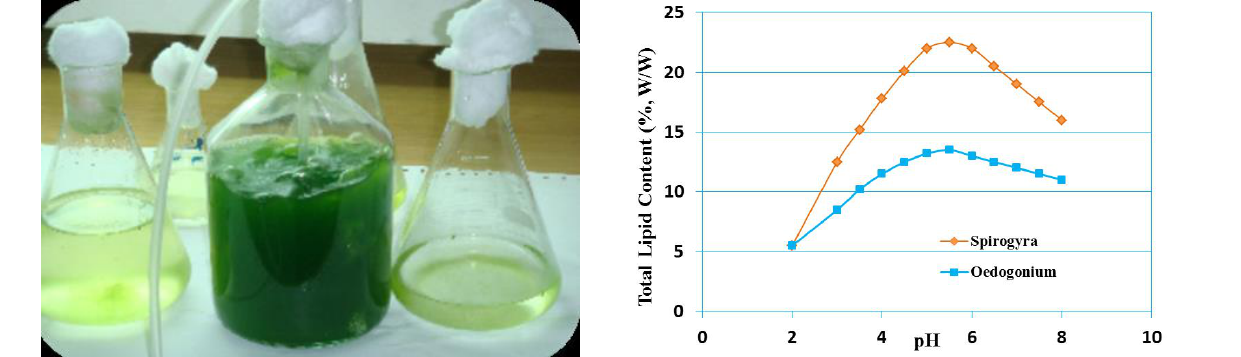
Figure 2. % of Total Lipid content of Spirogyra and Oedogonium Algae samples grown in the monosodium glutamate wastewater solution at different pH values.